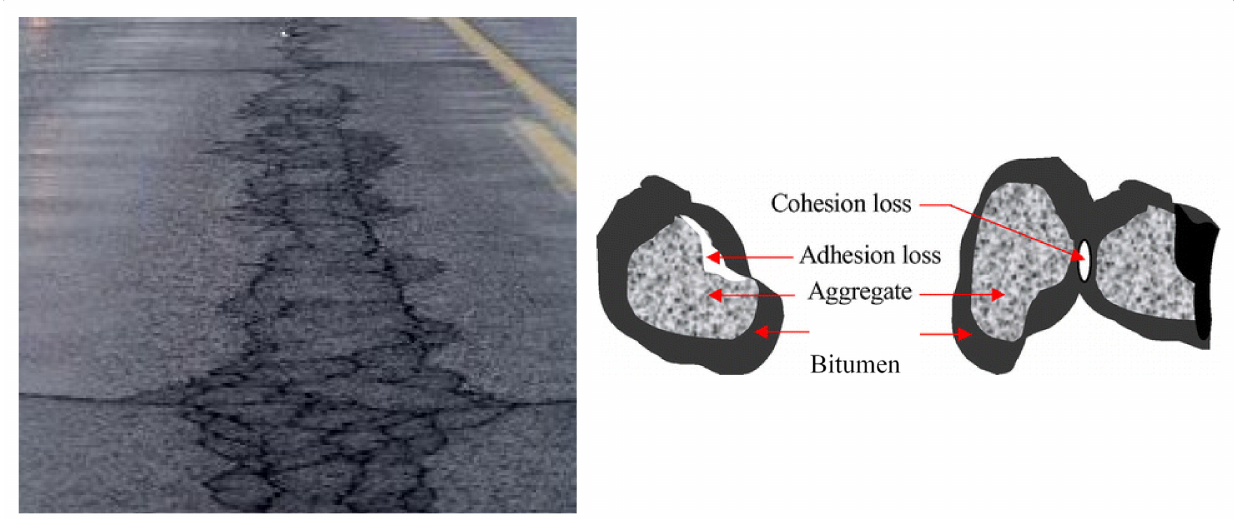
Figure 1. Fatigue cracks caused by low-adhesion in